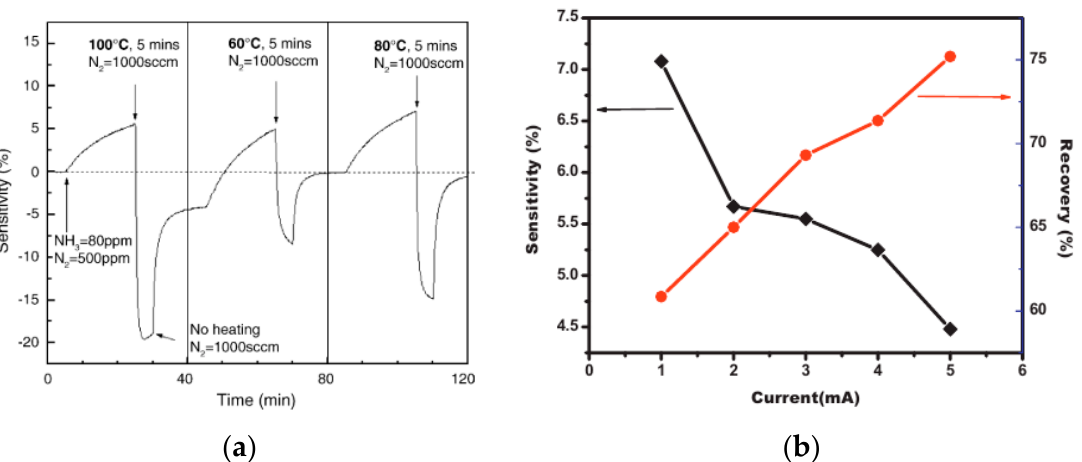
Figure 13. ( a ) Recovery of the SWCNT sensor at various conditions of gas desorption. In each period, NH 3 is turned on at 80 ppm in 500 sccm N 2 flux for 20 min. The desorption is proceeded at 1000 sccm N 2 flux, begins by heating for 5 min at 60–100 ◦ C; then, there was no heating for 15 min [87]. ( b ) Dependence of sensitivity and recovery percentage on the DC bias current (at 130 ◦ C) [134]. With the permission of Elsevier.